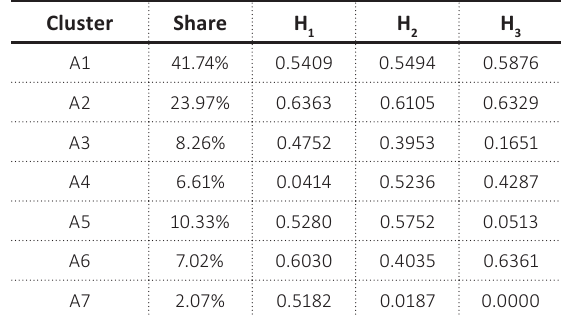
Table 2. Description of quantitative characteristics of clusters